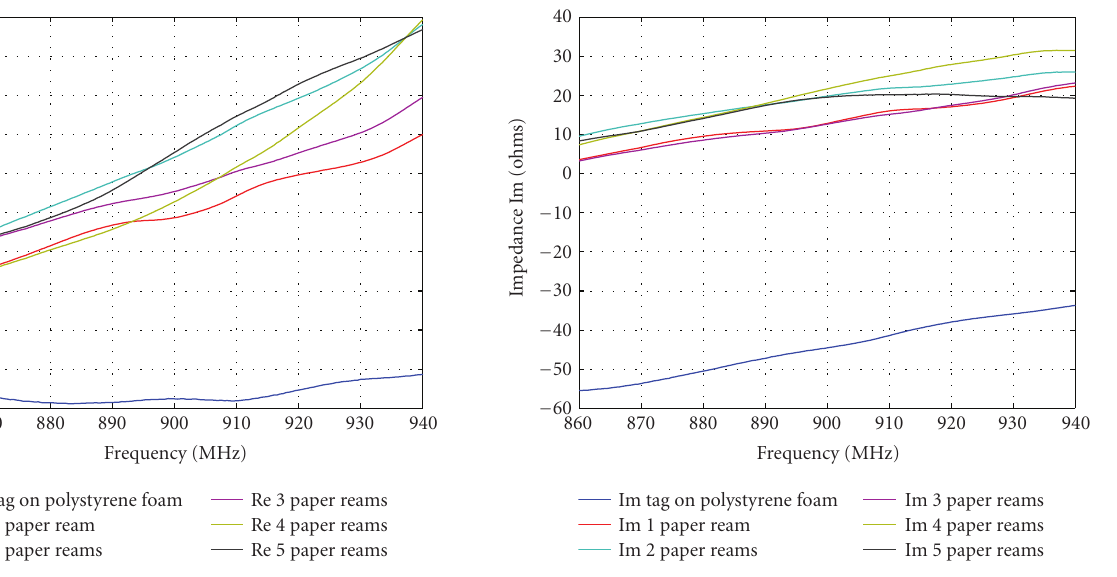
Figure 7: Real part of the bow-tie antenna’s input impedance. Figure 8: Imaginary part of the bow-tie antenna’s input impedance.